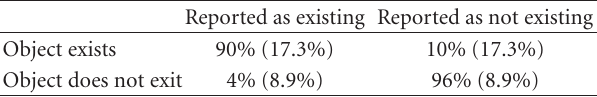
Table 1: Results of experiment for recognizing the existence of objects (with standard deviations in